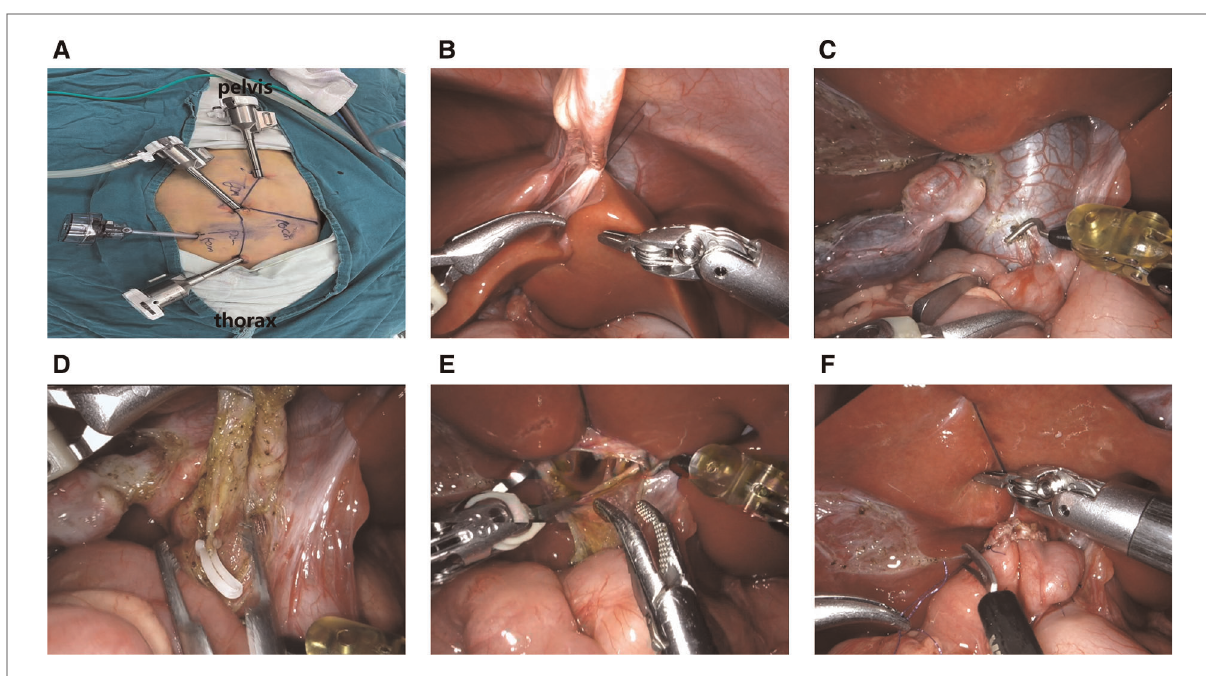
FIGURE 1 ( A ) location of robotic trocars; ( B ). Suspension of the ligament teres; ( C ). Cutting the cyst ’ s anterior wall; ( D ). Clipping of the narrowest part of the distal end of the cyst; ( E ). Detection of the common hepatic duct with a “ trumpet ” shape; ( F ). Common hepatic duct jejunal